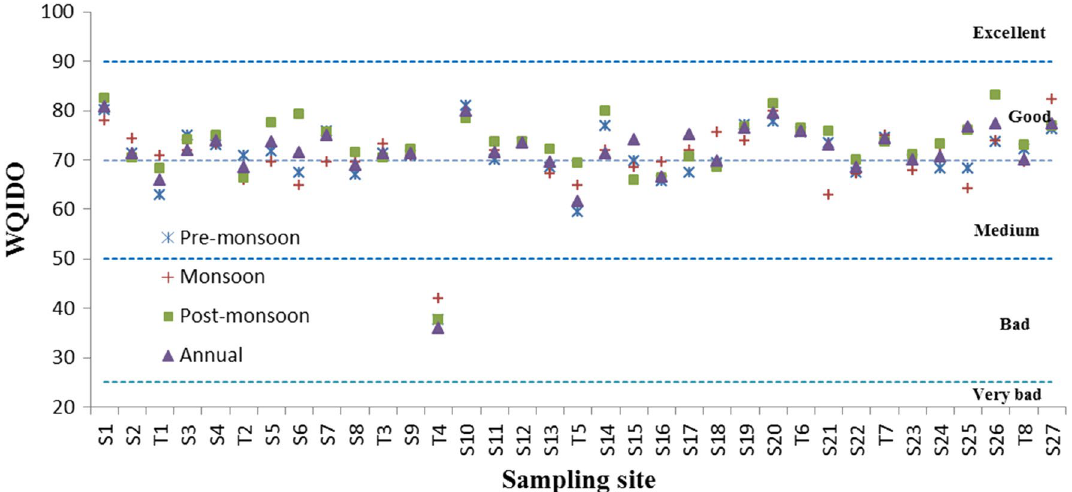
min at 35 sites in upper DRB